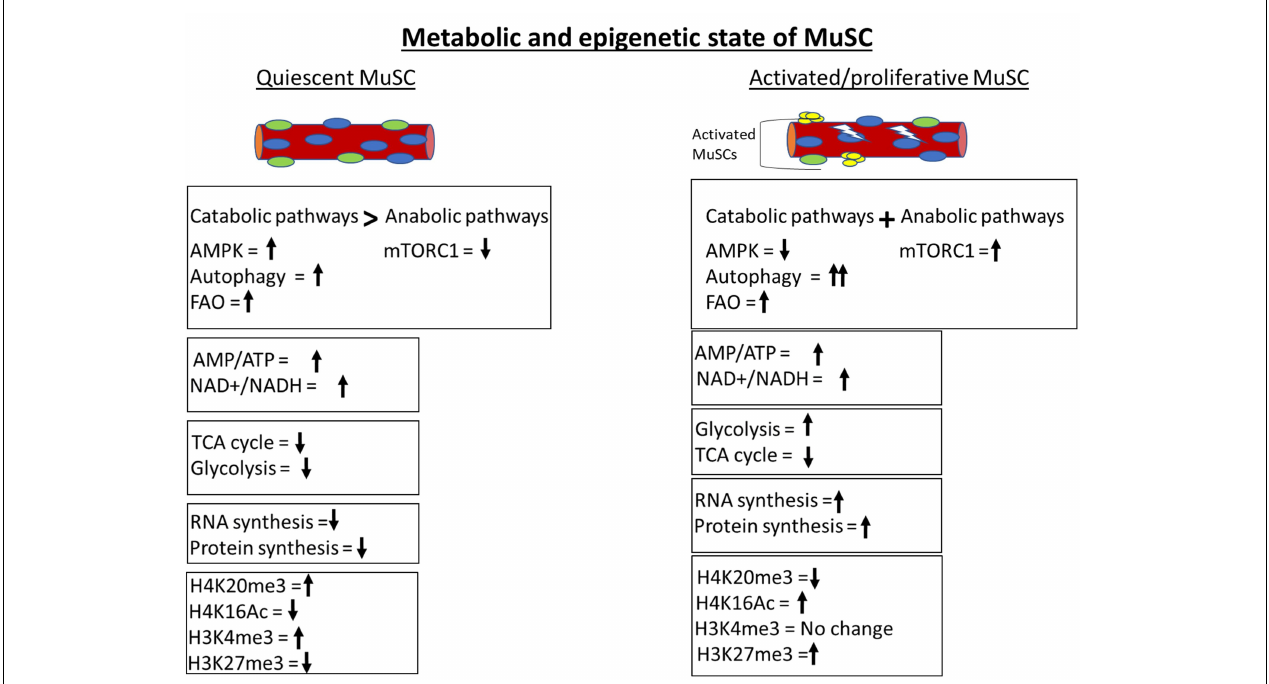
FIGURE 2 | Metabolic and epigenetic state of MuSCs. Quiescent MuSCs are metabolically and transcriptionally less active and conserve ATP by inhibiting anabolic processes. MuSCs fulfill their energy requirement through catabolic processes like autophagy and fatty acid oxidation (FAO). The histone deacetylase SIRT1 is upregulated in quiescent MuSCs and keeps H4 histone in a deacetylated state. The genome of quiescent MuSCs is highly condensed and transcriptionally less active due to H4K20me3-mediated constitutive heterochromatinization. The activation of MuSCs leads to immediate upregulation of glycolytic pathway to fulfill the cellular anabolic requirements. Anabolic processes are more prominent in activated MuSCs compared to catabolic processes as depicted by activation of master anabolic regulator mTORC1 and further increment in autophagy